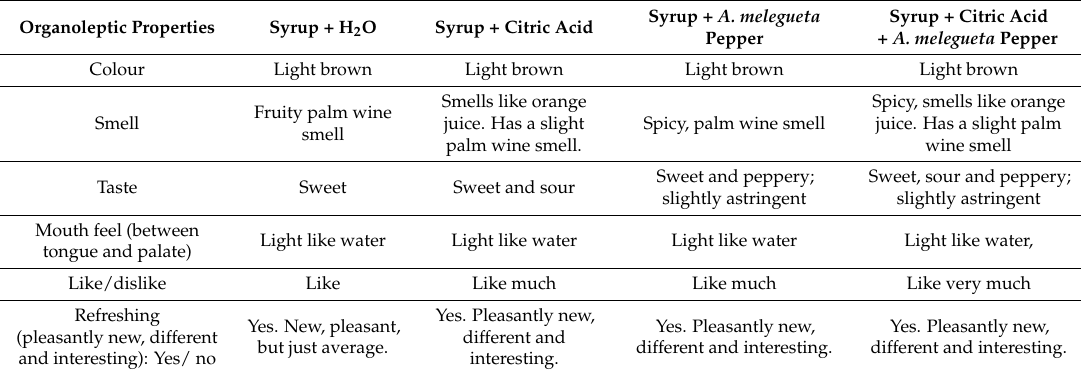
Table 9. Descriptive sensory characteristics of